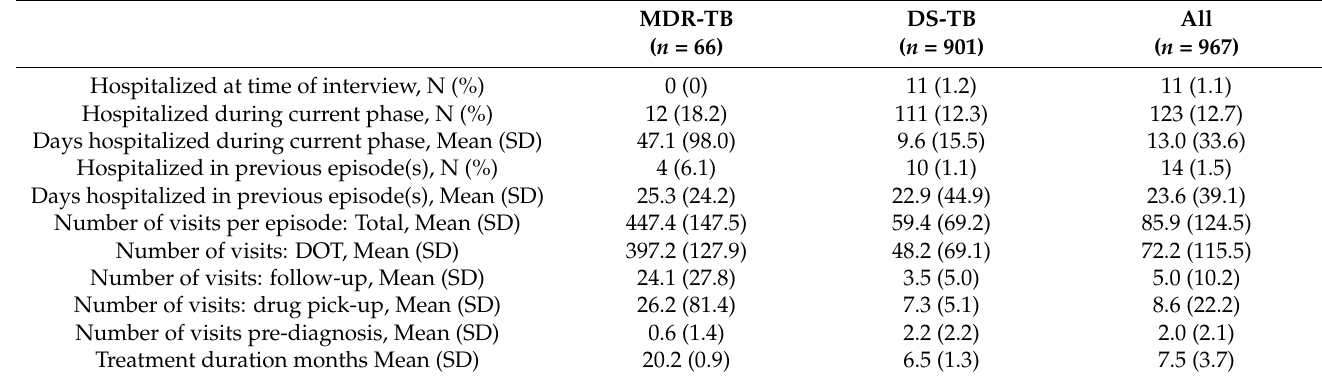
Table 2. Model of care for survey